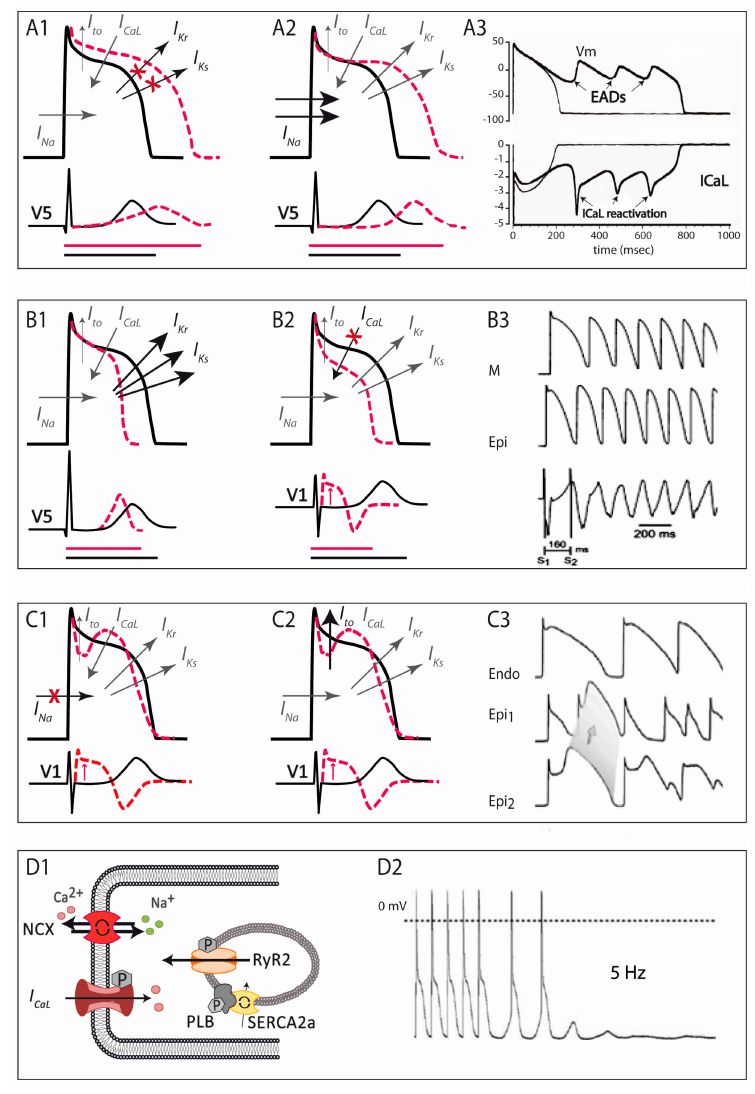
Figure 3. Schematic representation of the pathophysiological mechanisms involved in the four main primary electrical disorders. ( A ) in LQTS, either by a decrease in K + currents (A1) or an increase in Na + currents (A2), AP duration is prolonged, and so is the QTc interval on the ECG (depicted by the bottom horizontal lines: in black normal QT, in red long-QT interval). This situation favors the development of early afterdepolarizations, the trigger of ventricular arrhythmias in LQTS patients (A3). ( B ) in SQTS, an increase in K + currents accelerates repolarization (B1), and manifests as short QTc interval in the ECG (depicted by the bottom horizontal lines: in black normal QT, in red short-QT interval); in those cases of SQTS caused by loss-of-function mutations in the calcium channel (B2), besides shortening of the AP duration there is transmural gradient in early phases of repolarization, leading to ST-segment elevation like the one seen in BrS (combined phenotype, QT interval depicted by horizontal lines and ST segment elevation by the red arrow). In SQTS, an increased dispersion of repolarization favors the appearance of atrial and ventricular arrhythmias (B3). ( C ) In BrS, a decrease in Na + currents (C1) or, less commonly, an increase in I to currents (C2); produces a ionic imbalance in early repolarization, giving rise to the characteristic ST-segment elevation seen in the ECG (depicted by the red arrows). The consequent epicardial and transmural dispersion of repolarization favors ventricular arrhythmias by a mechanism of phase-2 reentry (C3). ( D ) CPVT is produced by abnormal Ca 2+ leak from the sarcoplasmic reticulum (D1), which favors the occurrence of delayed afterdepolarizations, which in turn can trigger ventricular arrhythmias (D2). Modified from